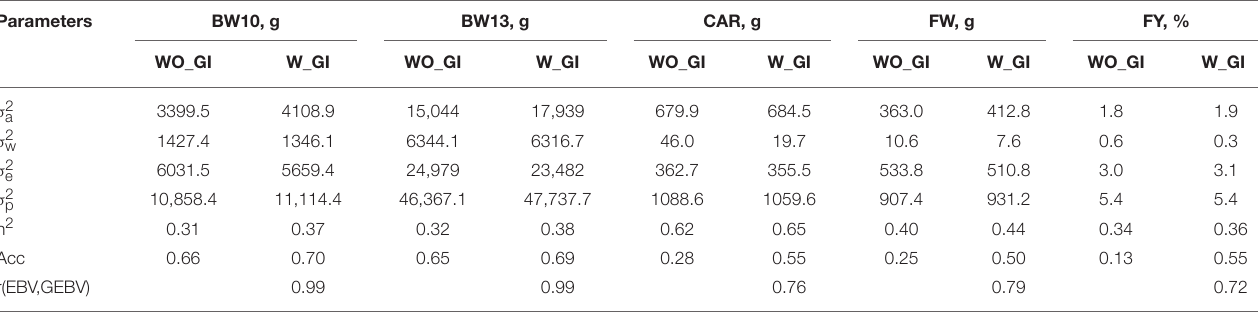
TABLE 2 | Genetic parameters of the traits body weight at 10 (BW10) and 13 (BW13) months post-hatching, carcass weight (CAR), fillet weight (FW), and fillet yield (FY) without (WO_GI) and with (W_GI) genomic information. Parameters